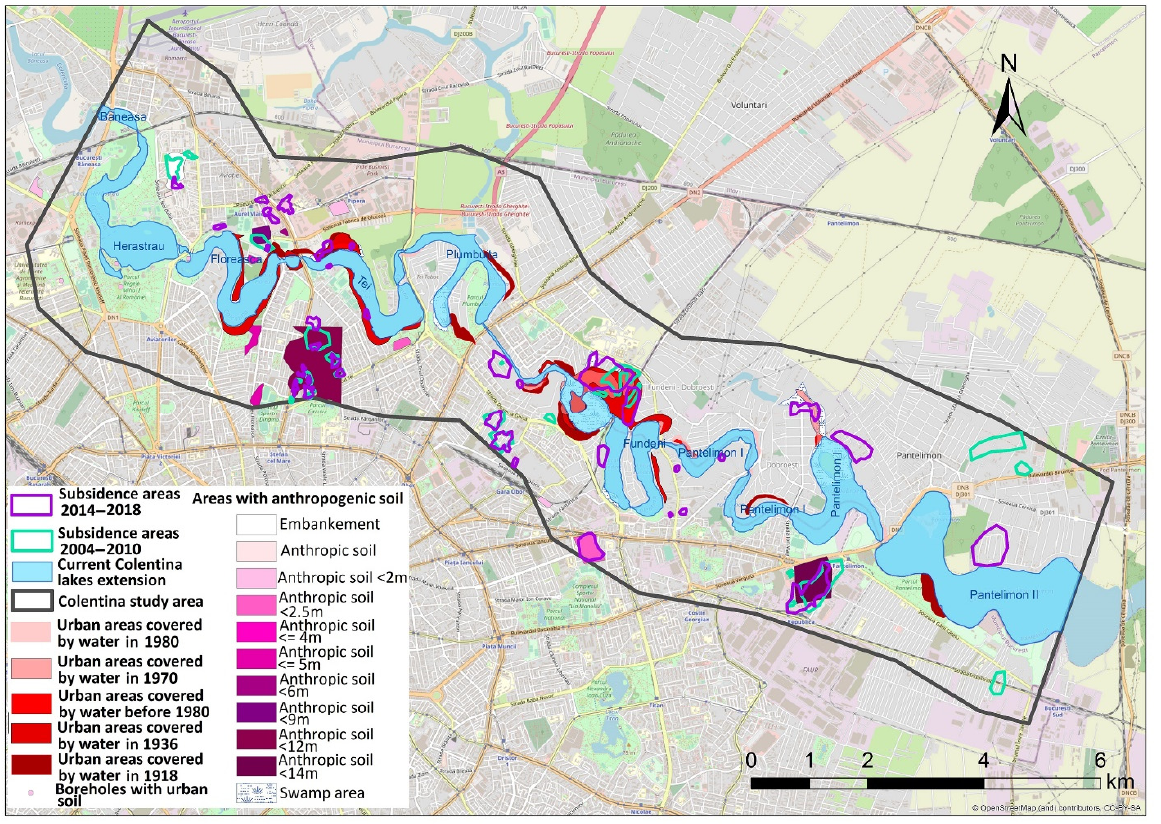
Figure 9. Areas showing subsidence and instability potential. Map generated in Esri ® ArcMap™ 10.3. Base map source: OpenStreetMap. Source: elaborated by the authors.